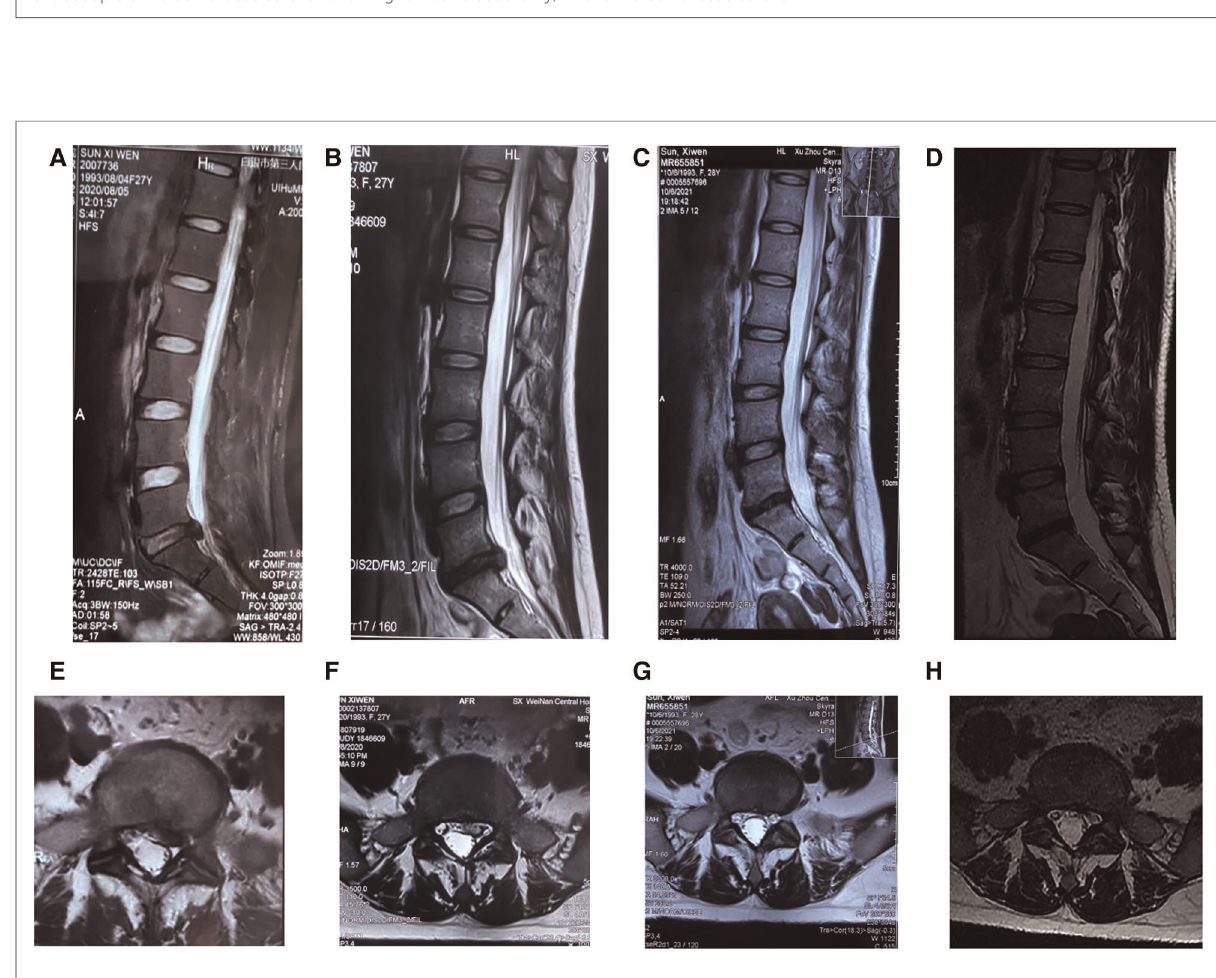
FIGURE 4 MRI of a 27-year-old woman with lumbar disc herniation with L5/S1 left center prolapse who was treated with full endoscopic nucleus pulposus resection combined with annulus fi brosus suture. ( A,E ) Preoperative sagittal and horizontal MRI showing grade III disc degeneration, compression and deformation of the dural sac, and compression of the right nerve root. ( B,F ) MRI at 3 months postoperatively shows the absence of prominent nucleus pulposus, no compression of the dura, and no obvious stenosis of the lateral recess. ( C,G ) MRI at 1 year postoperatively shows no signi fi cant disc herniation. ( D,H ) MRI at 18 months postoperatively shows the same as at 1